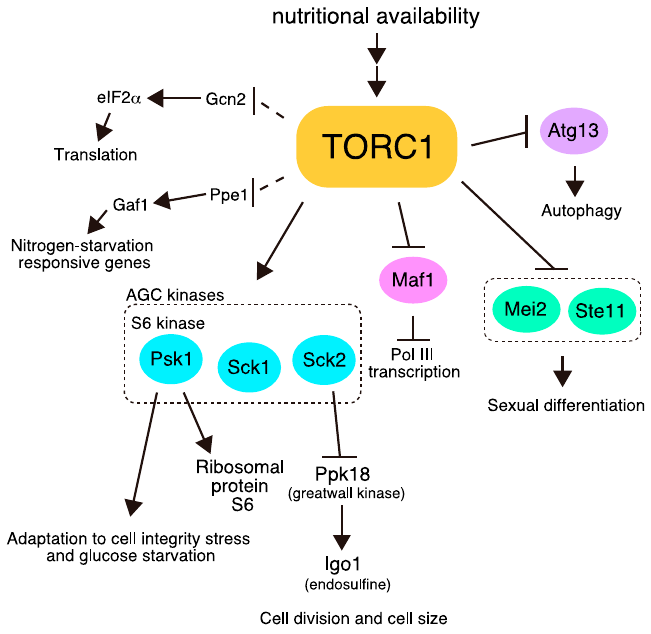
Figure 1. The major downstream pathways of target of rapamycin complex 1 (TORC1) in Schizosaccharomyces pombe . TORC1 phosphorylates multiple targets and regulates cell growth and sexual differentiation. Dashed lines represent pathways in which direct phosphorylation by TORC1 has not been